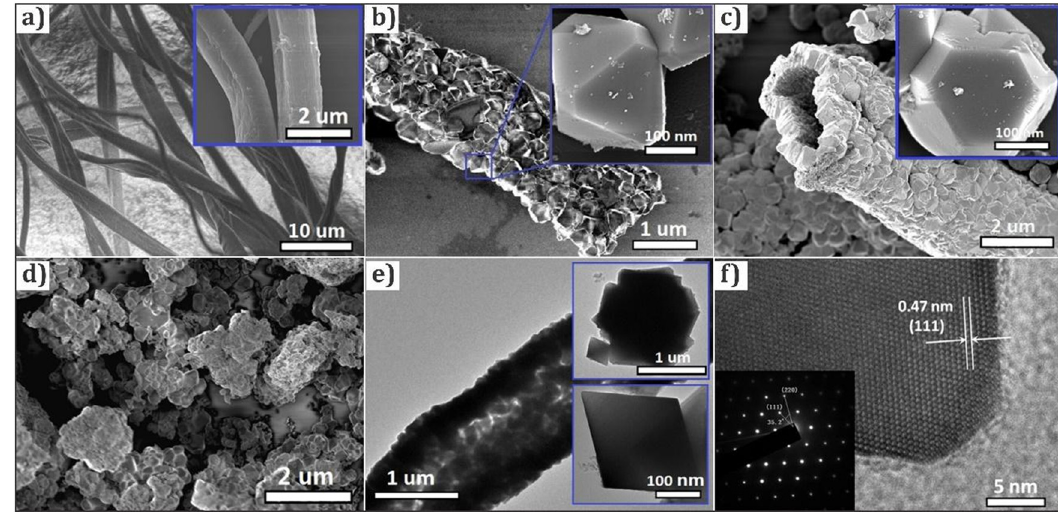
Figure 10: SEM images of Co 3 O 4 nanostructures: ( a ) cotton fi bers, preparation of mesoporous carbon microtubes from cotton fi bers previously calcined at T = 400°C for ( b ) 2 h and ( c ) 3 h; ( d ) unsupported Co 3 O 4 nanostructures. TEM images: ( e ) in low magni fi cation and ( f ) in high resolution ( HRTEM ) , showing the composite formed by the Co 3 O 4 nanostructures supported in the mesoporous carbon nanotubes previously calcined at T = 400°C for 2 h [ 99 ]